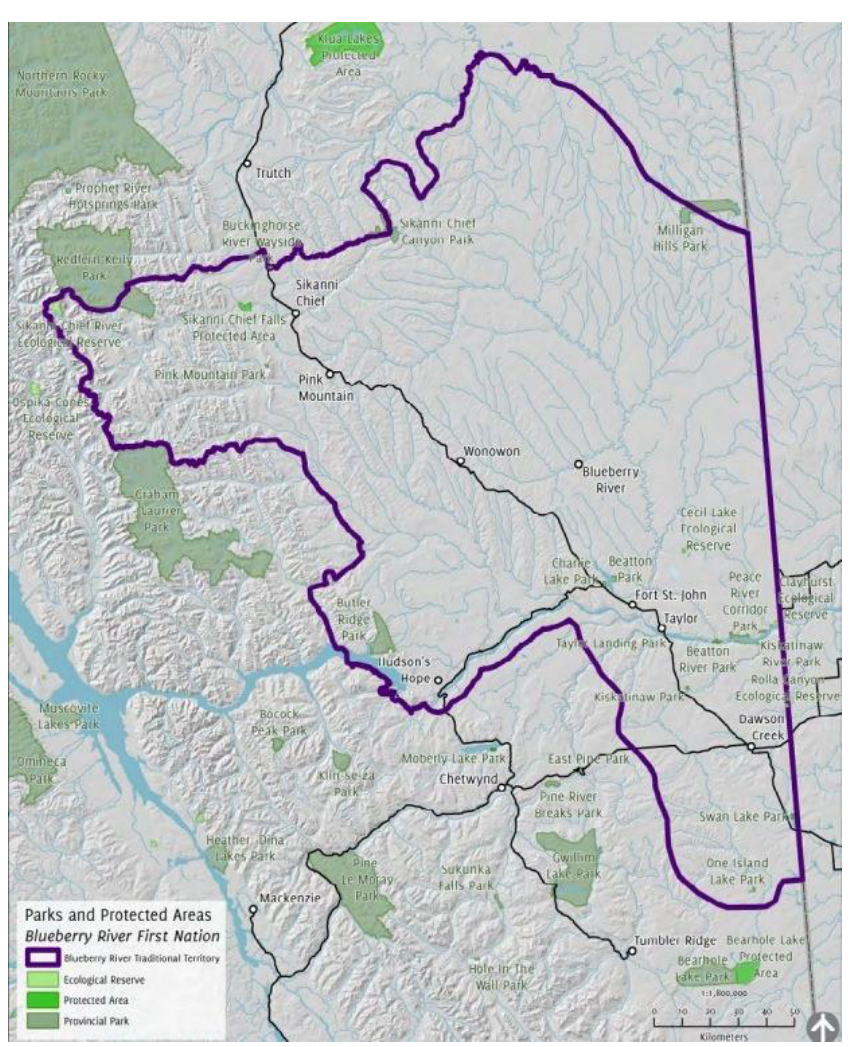
Figure 1. Parks and protected areas: Blueberry rivers first nations (from the 2017 Atlas of cumulative land disturbance).